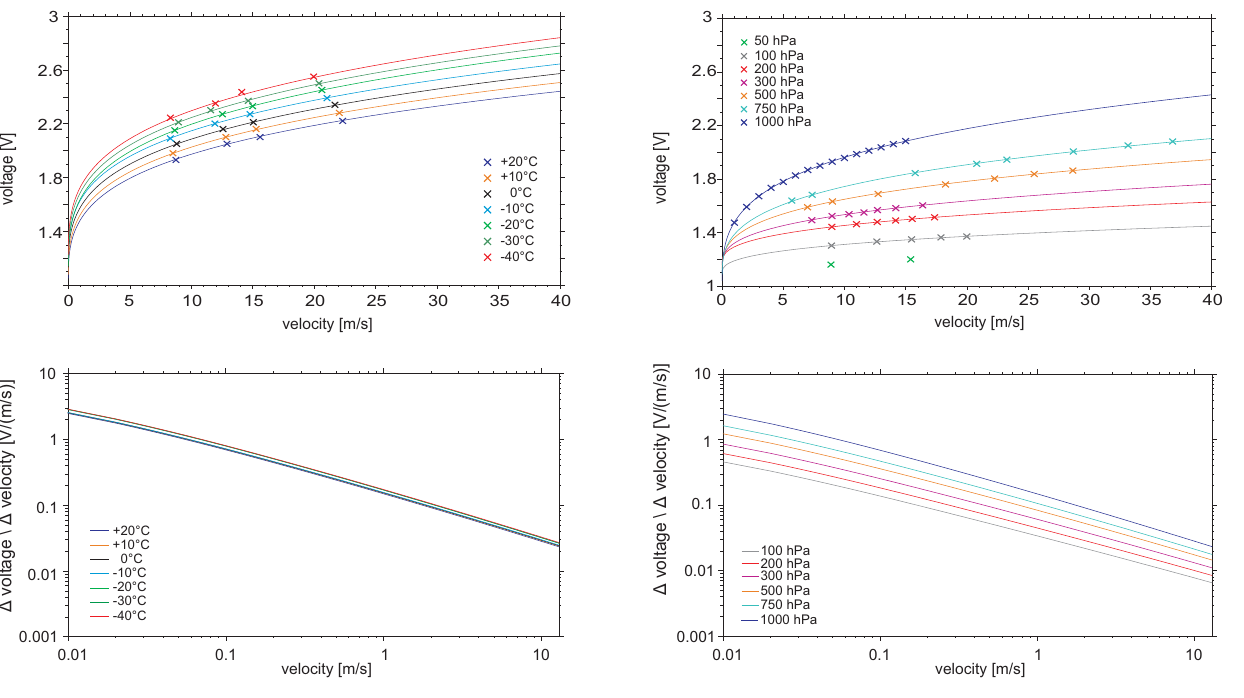
Fig. 3. Results of the climate chamber tests. The King’s law (thin line) was fitted to the CTA voltage signals (data points) as a func- tion of velocity for different temperatures (top). The bottom figure shows the sensitivity of the CTA signal as a function of velocity at different temperatures.